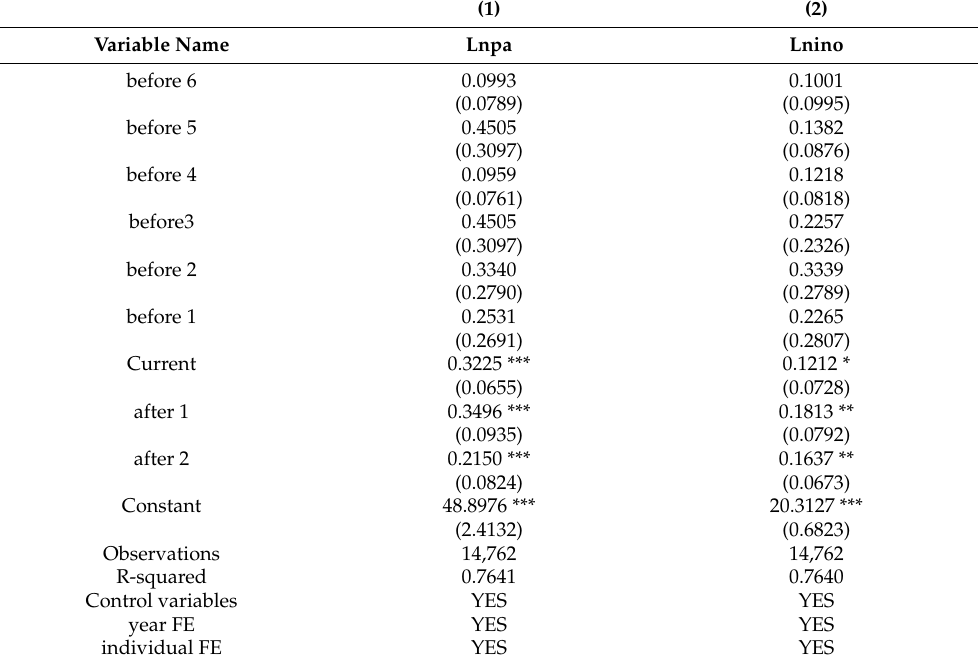
Table 4. Parallel trend test.